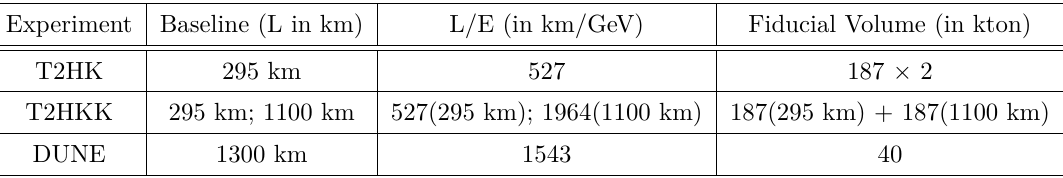
Table 2 . The baselines, L/E and fiducial volumes of each detector for T2HK, T2HKK, and